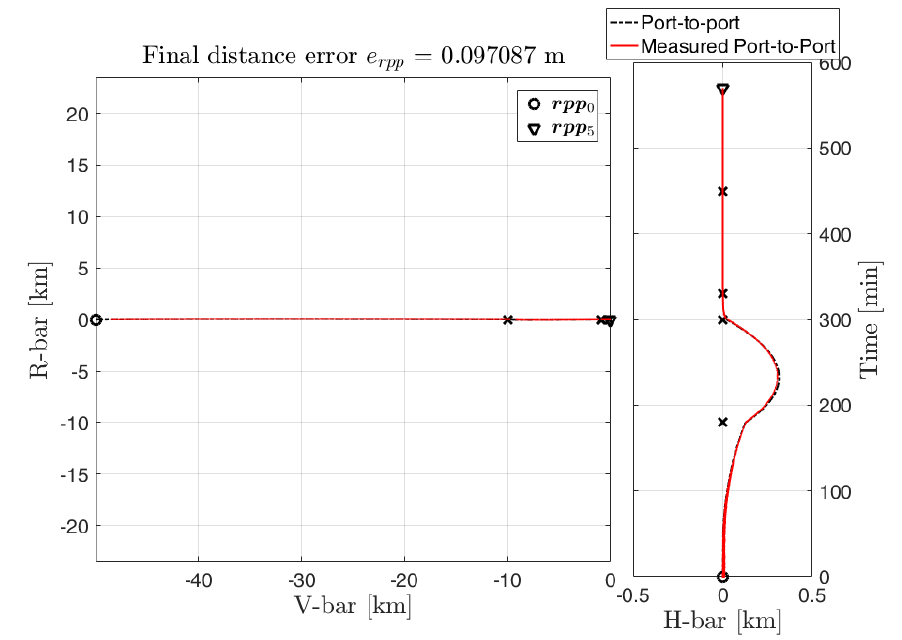
Figure 18. Port-to-port maneuver with the measured